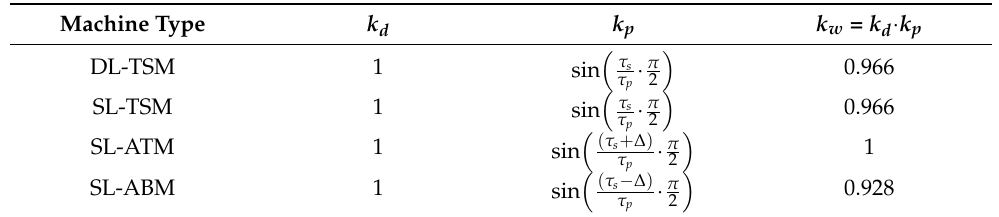
Table 2. Winding Coefficient for Dual Three-Phase Machine with Different Winding Structure and Stator